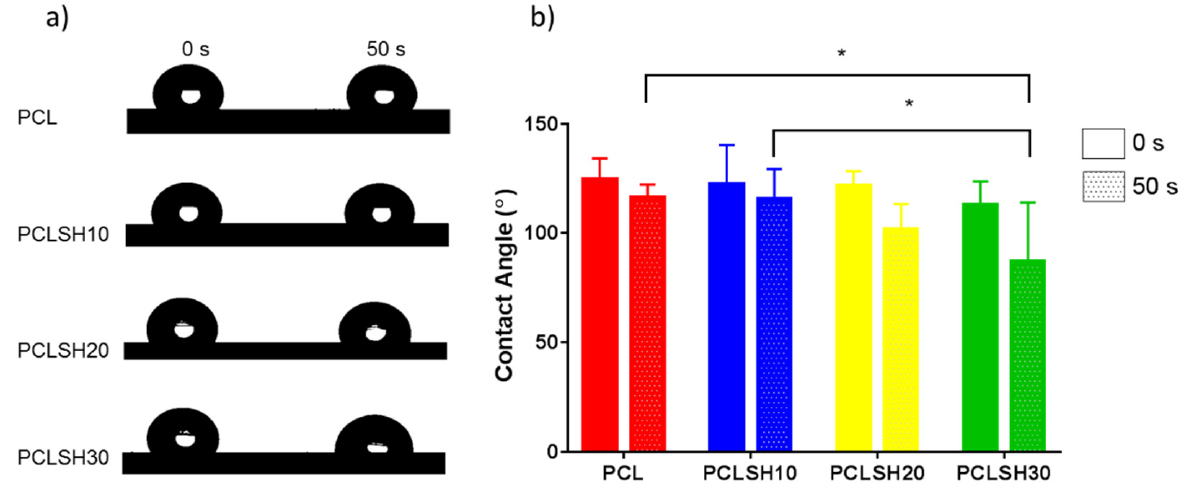
Figure 5. Wettability of electrospun meshes. ( a ) Droplet on the mesh surfaces and ( b ) contact angle measurements at 0 s and 50 s.